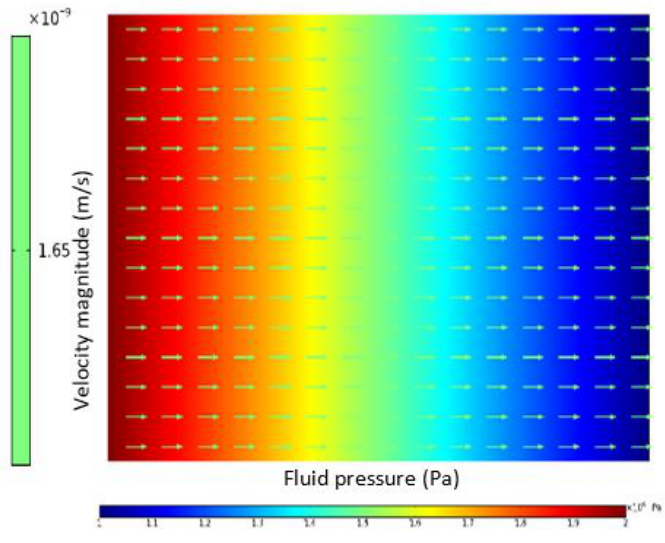
Figure 5. Fluid pressure and velocity field at steady states from COMSOL